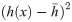
Apterous is required for the characteristic straight shape of the DV boundary and for the local increase in cell bond tension.(A,B) Wing discs from apGal4 (control) and apUGO35/apGal4 mutant larvae expressing GFP (red) in the dorsal compartment stained for E-cadherin (green) to visualize adherens junctions. Scale bars: 10 μm. (C,D) Segmentation of the images shown in (A) and (B). The red line marks the DV boundary. (E) Scheme depicting the measurement of roughness w of a boundary. The shape of the boundary is described by the function h(x) as the orthogonal distance of the boundary from the x axis, connecting the end points of the boundary, for any position x. For two points within the segment length L roughness is given by the average deviation from the mean value, (h(x)−h¯)2, where h¯ is the average of h(x) within the segment length L. We then average roughness along the boundary for any L indicated. (F) Roughness w of the DV boundary for the segment lengths L for the genotypes indicated in (A,B). Segment length and roughness values are normalized by the average cell bond length in the tissue l¯ = 1.7 μm. Mean and s.e.m. are shown (control, n = 6 wing discs; mutant, n = 7 wing discs). P <0.05 for L = 1–10. (G,H) Change in distance d between the vertices of cell bonds located within the compartments (comp.) or at the DV boundary after ablation (normalized to l¯) as a function of time for wing discs of apGal4 (control) and apUGO35/apGal4 mutant larvae. Mean and s.e.m. are shown (control, n = 10 comp., n = 11 DV; mutant, n = 9 comp., n = 6 DV cuts). (I,J) Initial velocity of vertex displacement after ablation of the indicated types of cell bonds for control (I) and apUGO35/apGal4 mutant (J) larvae. Mean and s.e.m. are shown (n as in G,H). ** P<0.01; n.s. not significant.